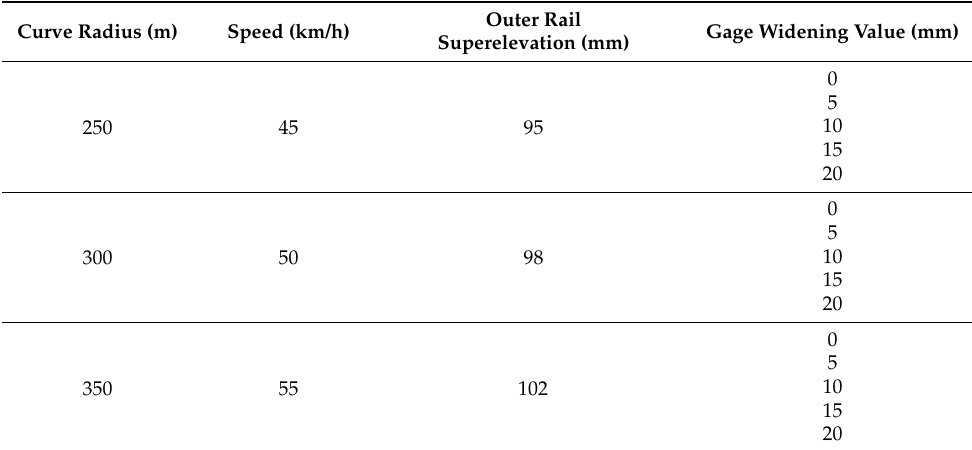
Table 18. Rail wear simulation conditions.